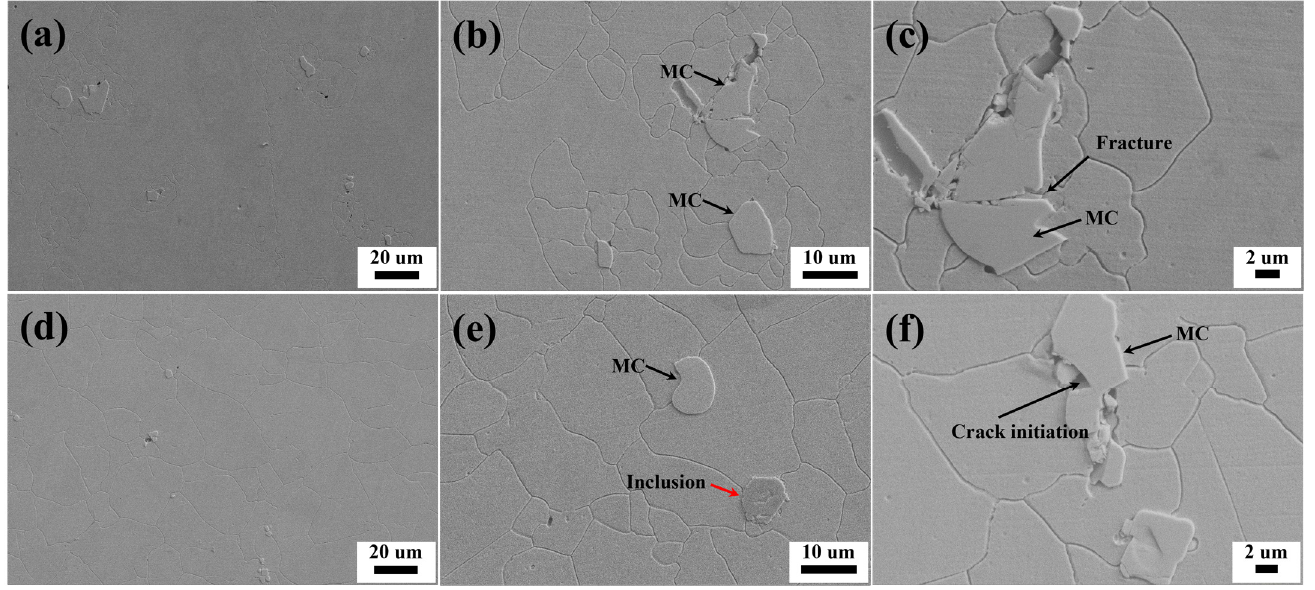
Figure 10. SEM micrographs of as-forged GH4169 with etchants 3 and 4. Partial recrystallization: ( a ) More carbides 2KX. ( b ) Lots of grain boundaries around MC 5KX. ( c ) Cracked carbides 11KX. Fully DRX: ( d ) Fewer carbides 2KX. ( e ) Homogeneous nucleation 5KX. ( f ) Crack initiation 10KX.